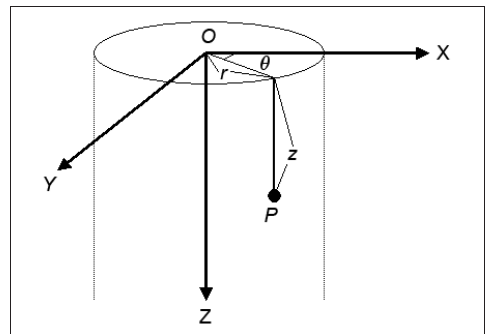
Fig. 2. The Cartesian and cylindrical coordinate system used in Section